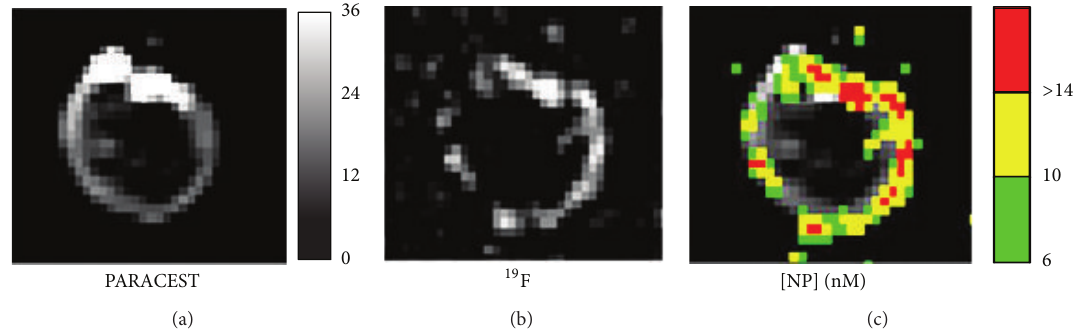
Figure 3: Dual PARACEST and fluorine MRI of fibrin targeted PARACEST perfluorocarbon nanoparticles bound to the surface of a clot. The PARACEST contrast to noise ratio map (a) and fluorine image (b) both show nanoparticles bound to the surface of the clot. The fluorine signal intensity was calibrated to measure the nanoparticle concentration on the clot surface in nM. The particle concentration map is color- coded and overlaid onto the PARACEST subtraction image (c), demonstrating colocalization of these two definitive signals and allowing the water exchange kinetics to be estimated after binding to a biological target. Reprinted with permission from